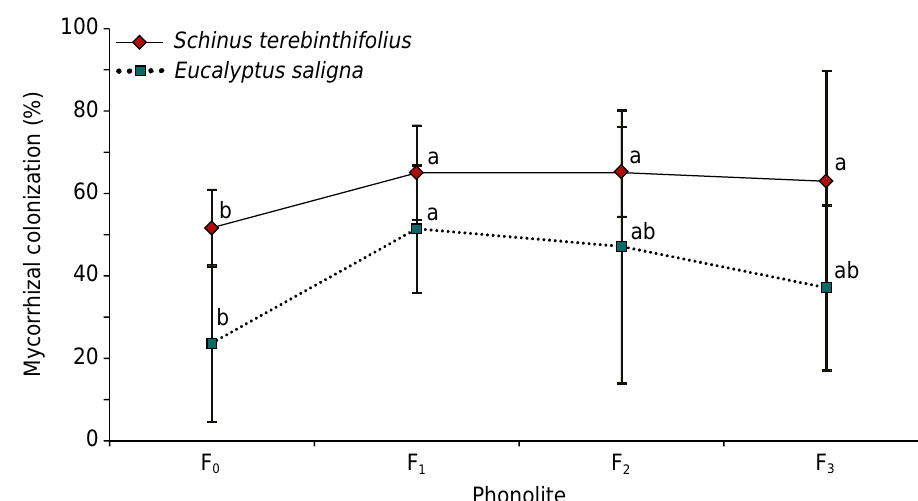
Figure 2. Mycorrhizal colonization of Schinus terebinthifolius and Eucalyptus saligna in mycorrhizal (SP, LC, and IN) and phonolite (F 0 , F 1 , F 2 , and F 3 ) treatments. F 0 : no phonolite, and addition of phonolite in particle sizes of 0.037 mm (F 1 ), 0.074 mm (F 2 ), and 0.149 mm (F 3 ). For each species, means followed by the same letter are not statistically different according to the Tukey post hoc test